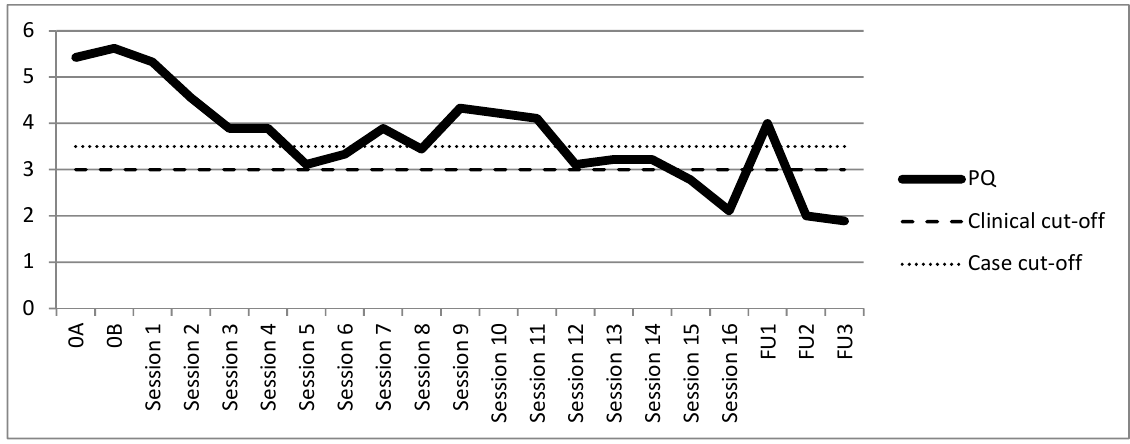
Figure 2: Sara’s weekly PQ score Note. 0A and 0B = assessment sessions. PQ = Personal Questionnaire (Elliott, Shapiro, & Mack, 1999). FU = follow-